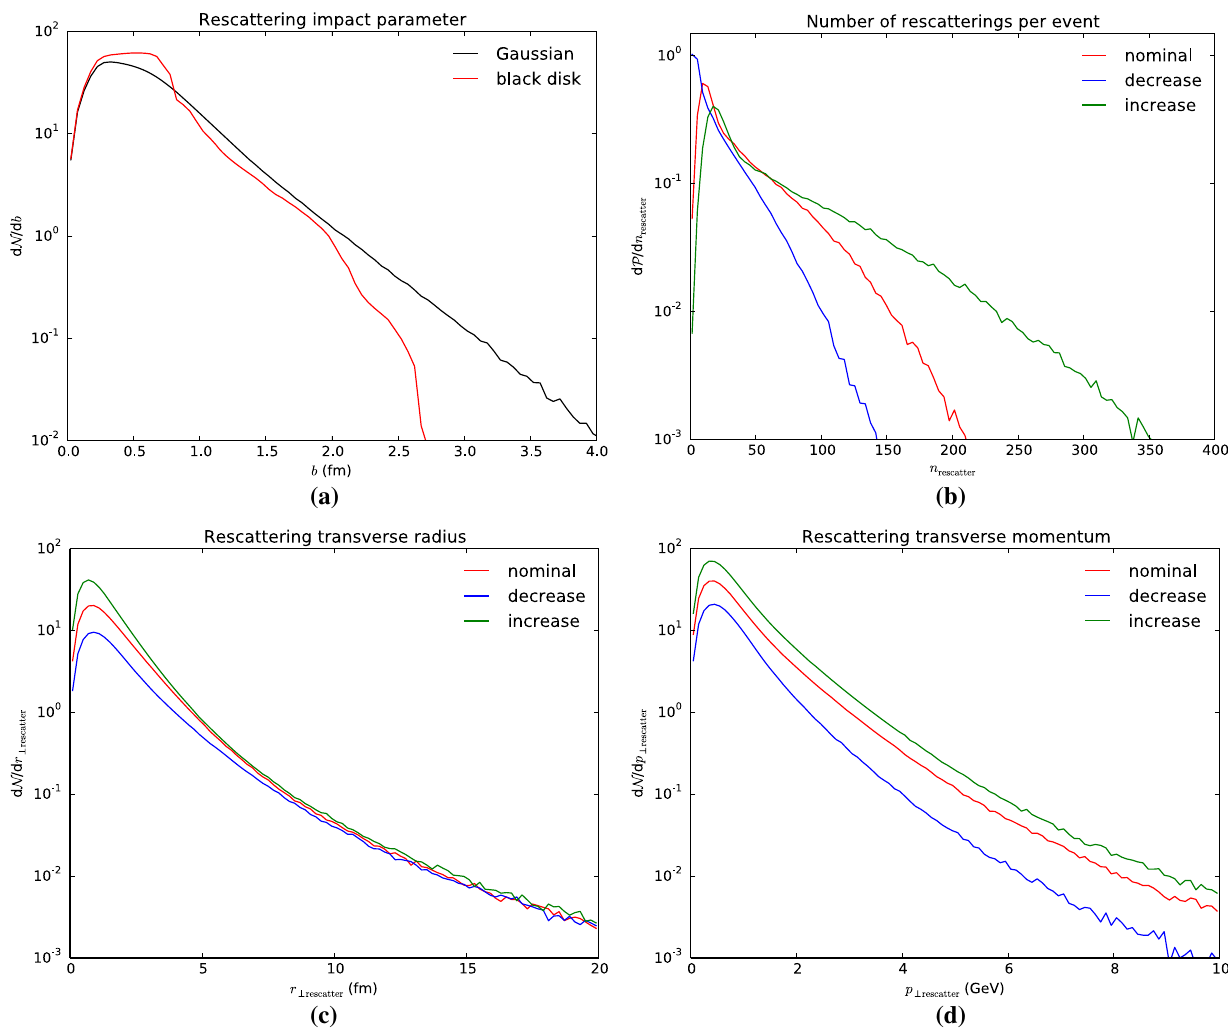
Fig. 14 a The impact-parameter distribution of rescatterings for the different impact models. b Number of rescatterings per event. c , d Distribution of rescatterings in r ⊥ and p ⊥ . Results are for 13 TeV nondiffractive pp events Table 13 List of model settings Setting Decrease Nominal used to explore the range of possible rescattering effects. Here “increase” and “decrease” denote alternatives with more or less amount of rescattering relative to the default “nominal” values